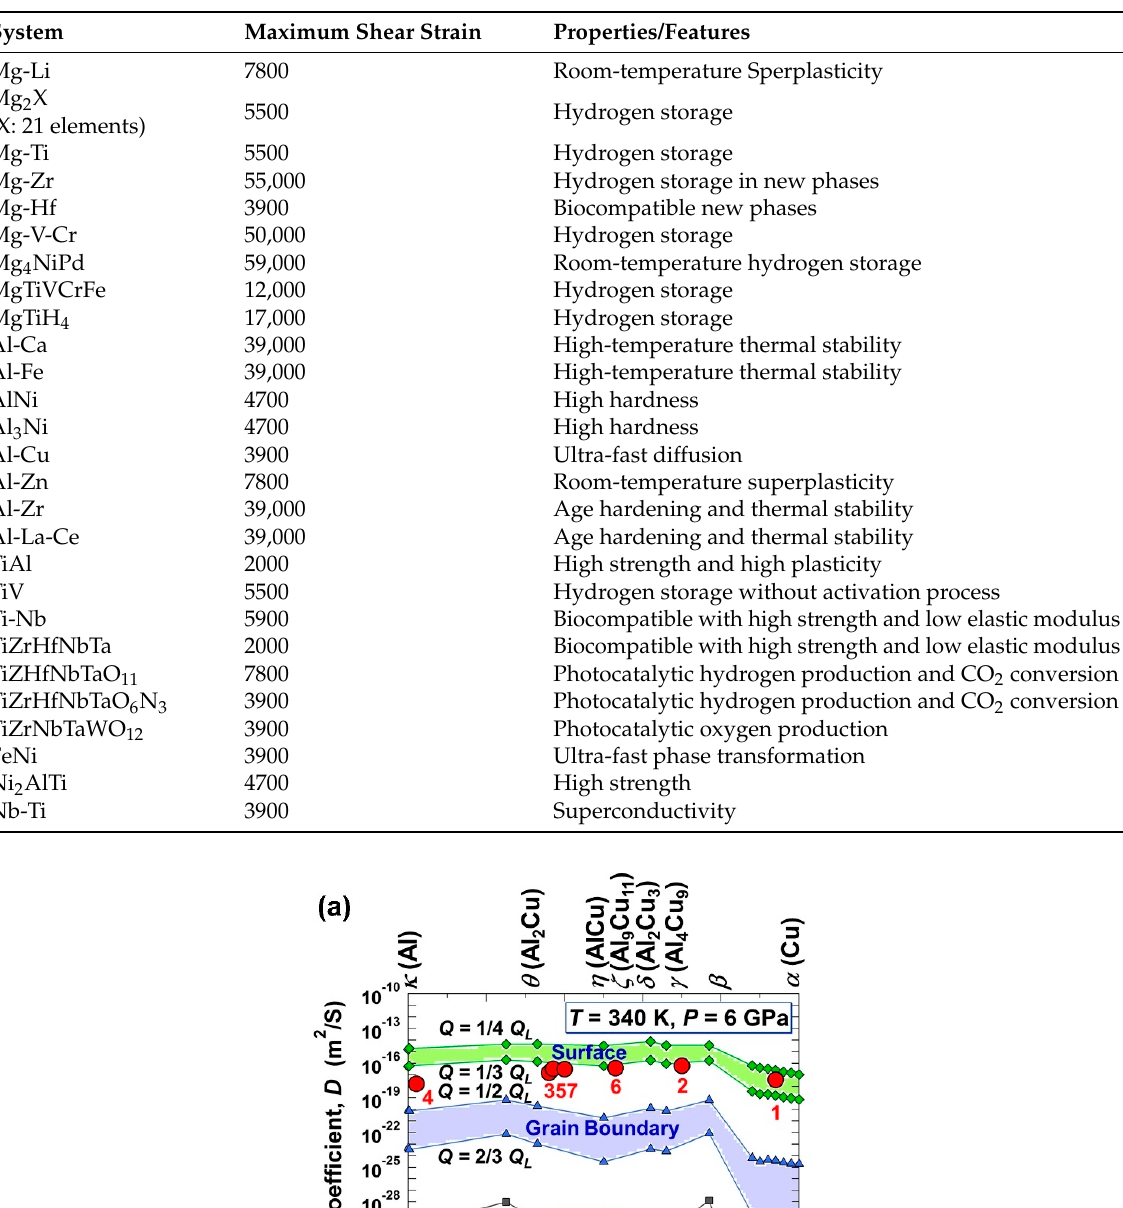
Table 1. Materials processed by ultra-SPD to shear strain strains over 1000 and their main properties or features.